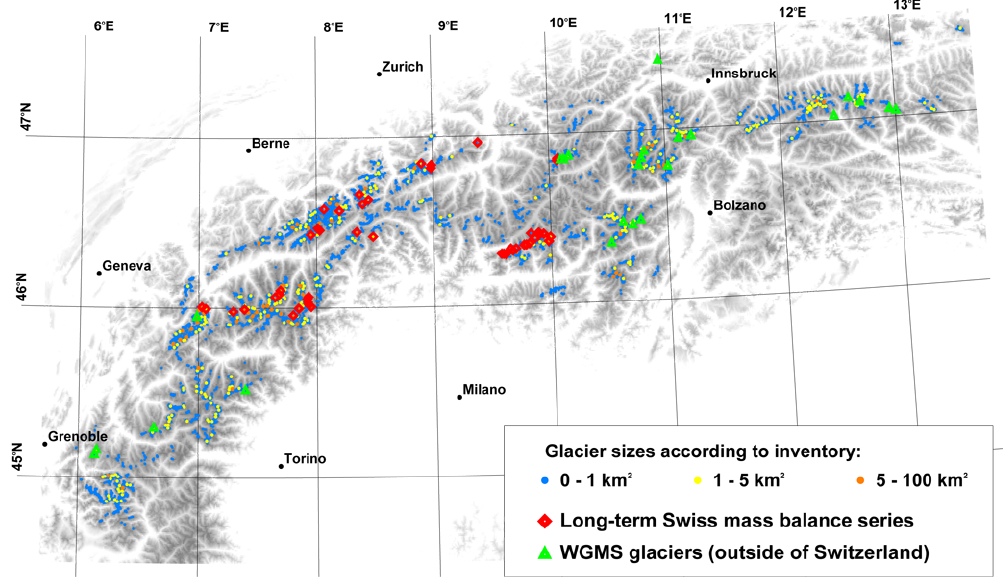
Fig. 1. Overview map of glacier coverage and glacier mass balance data in the European Alps. All inventoried glaciers according to Paul et al. (2011) are shown; the colour-coding indicates glacier size. Swiss glaciers with long-term mass balance series (Huss et al., 2010a,b) and additional mass balance glaciers (WGMS, 2008) are